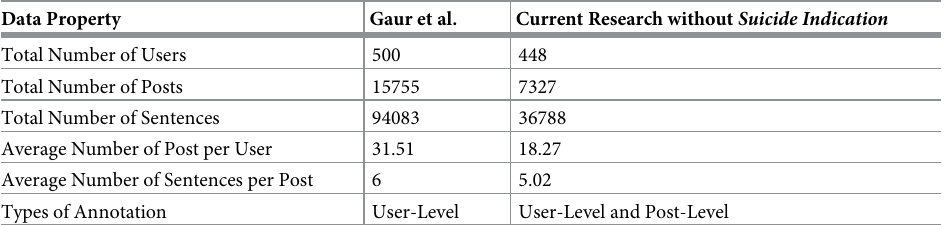
Table 1. Data statistics on the annotated Reddit data for current research and Gaur et al. The users labeled as sui- cide indication in 500 Reddit user dataset were removed because of high disagreement between annotators during post-level annotation.